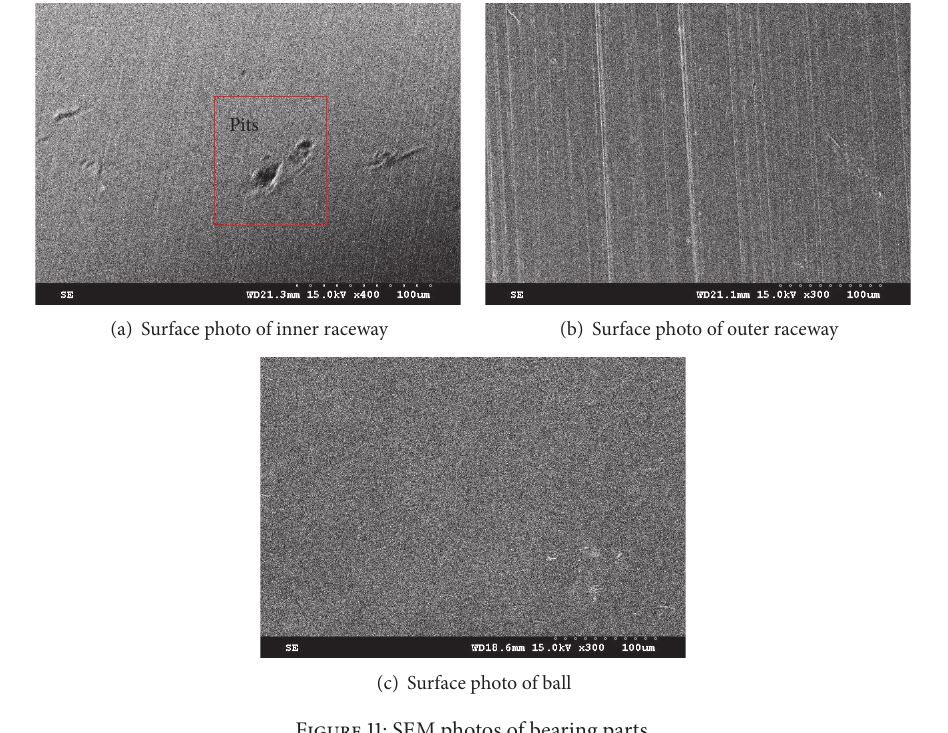
Figure 11: SEM photos of bearing